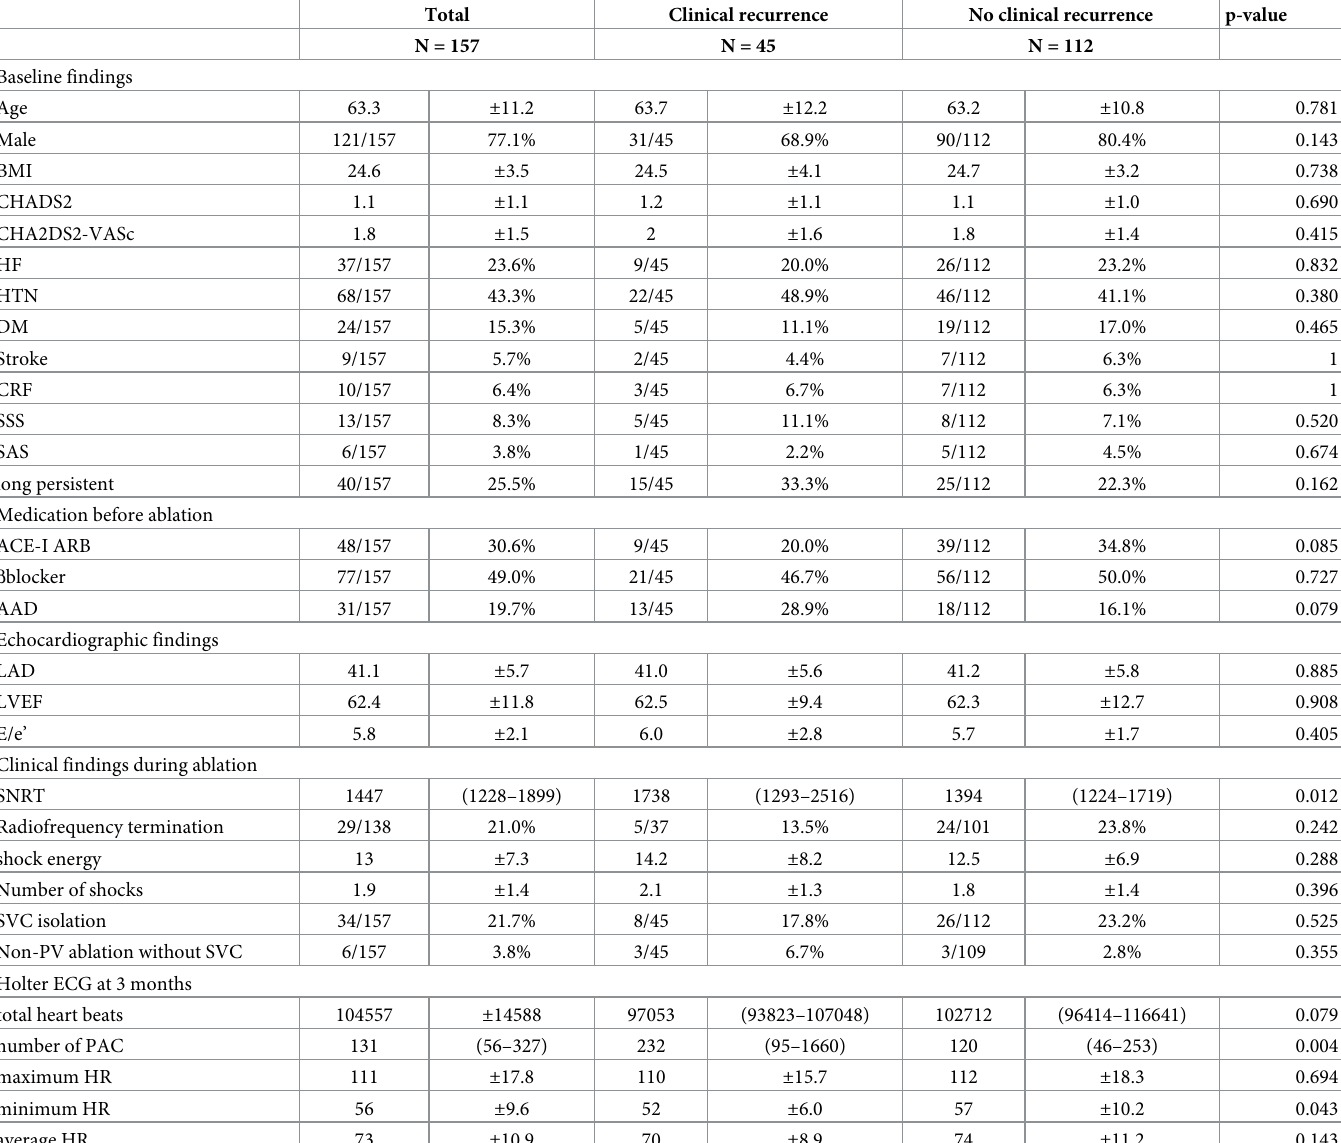
Table 1. Patient characteristics and comparison between clinical recurrence and no clinical